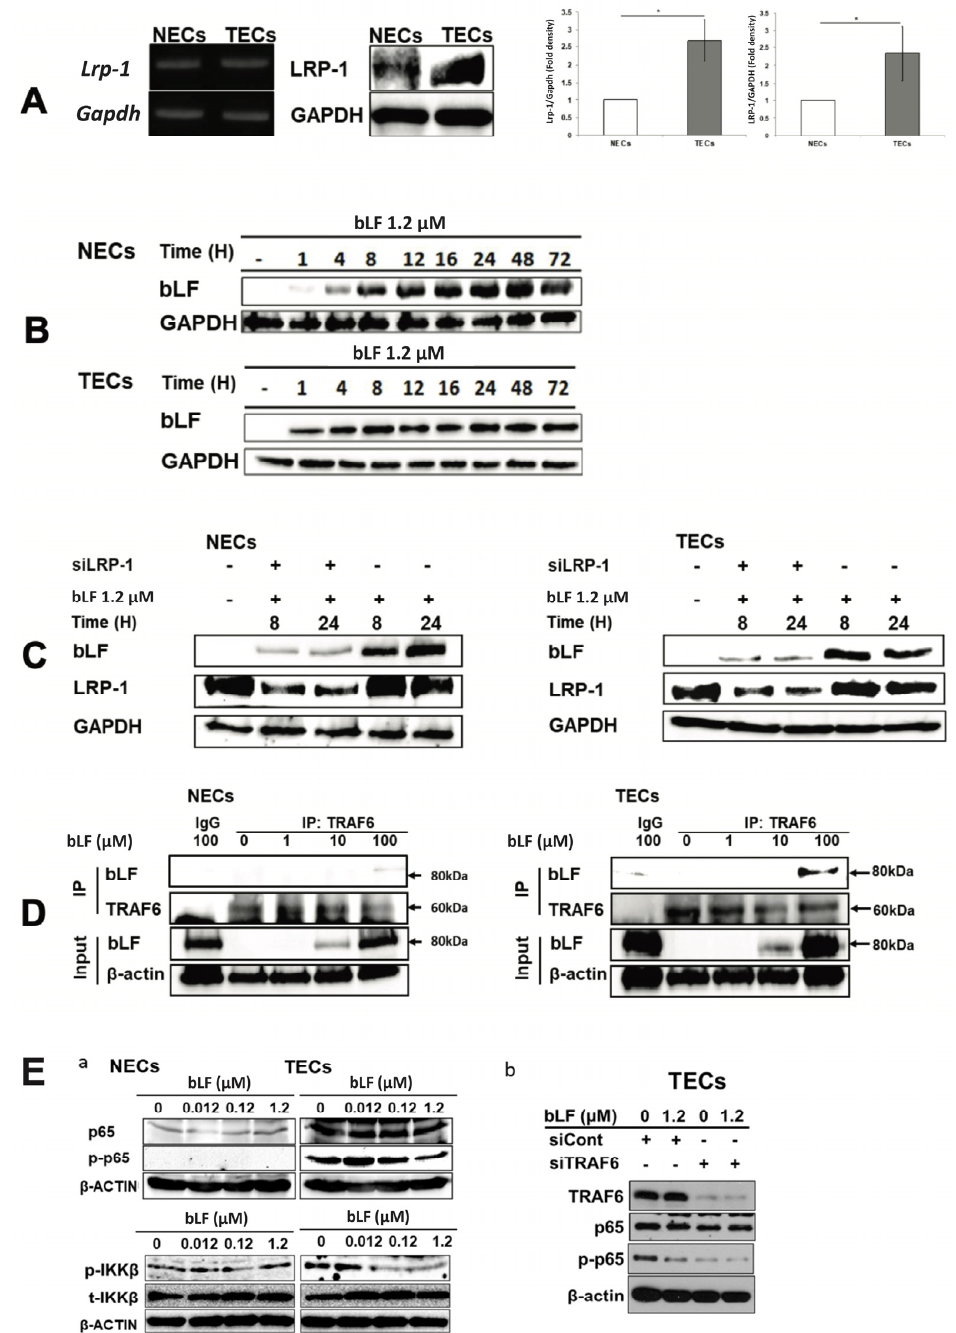
Figure 4. bLF receptor and its role as an internalization factor for bLF in NECs and TECs. ( A ) LRP-1 mRNA and protein expression in NECs and TECs. Semi-quantitative analysis was also conducted. Data quantification was performed using imageJ software (National Institutes of Health, US). Data represent the mean ± standard deviation (SD) of three-independent experiments, each performed in triplicate. Statistical significances were determined by one-way analysis of variance (ANOVA). * p < 0.05. ( B ) Detection of internalized bLF by Western blotting in NECs and TECs at 1, 4, 8, 12, 16, 24, 48 and 72 h after 1.2 µM bLF treatment. ( C ) LRP-1 expression and bLF internalization by Western blotting in siLRP-1 NECs and TECs at 8 and 24 h after 1.2 µM bLF treatment. ( D ) Immunoprecipitation of bLF and TRAF6. ( E ) p-p65 protein levels by Western blotting in NECs and TECs after 0.012, 0.12 and 1.2 µM bLF treatment ( a ). p-p65 expression level in siTRAF6 transfected TECs with 1.2 µM bLF treatment ( b ).